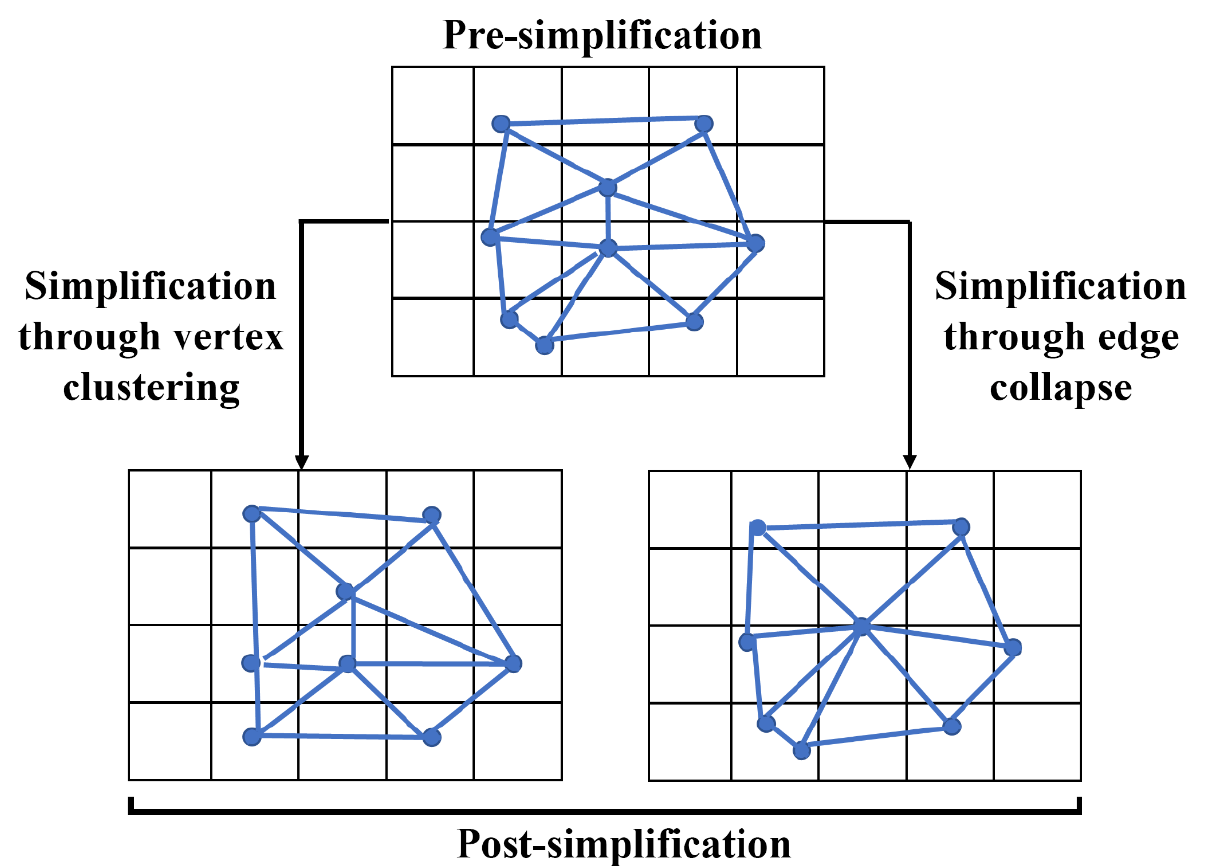
Figure 6. Illustration of a model that underwent vertex clustering and edge collapse simplification. Although both approaches produce fewer vertices than the initial model, clustering decimation was likely to introduce changes to the model's shape. Whereas the model underwent edge collapse, sim- plification appeared to retain its shape.